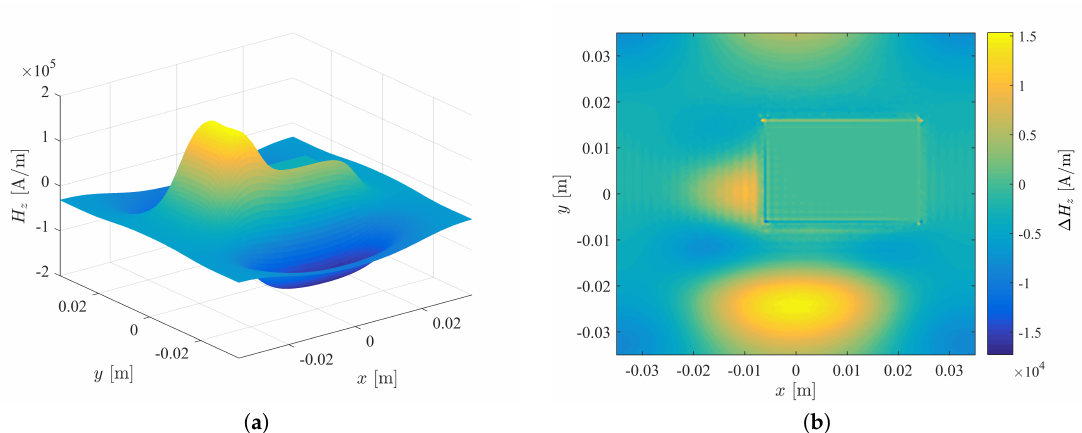
Figure 3. Magnetic field strength in the z -direction on an xy -plane in the center of the region with magnetic material (Region 2). ( a ) calculated H z with the scattering matrix approach; ( b ) difference in calculated H z between the scattering matrix approach and the finite element